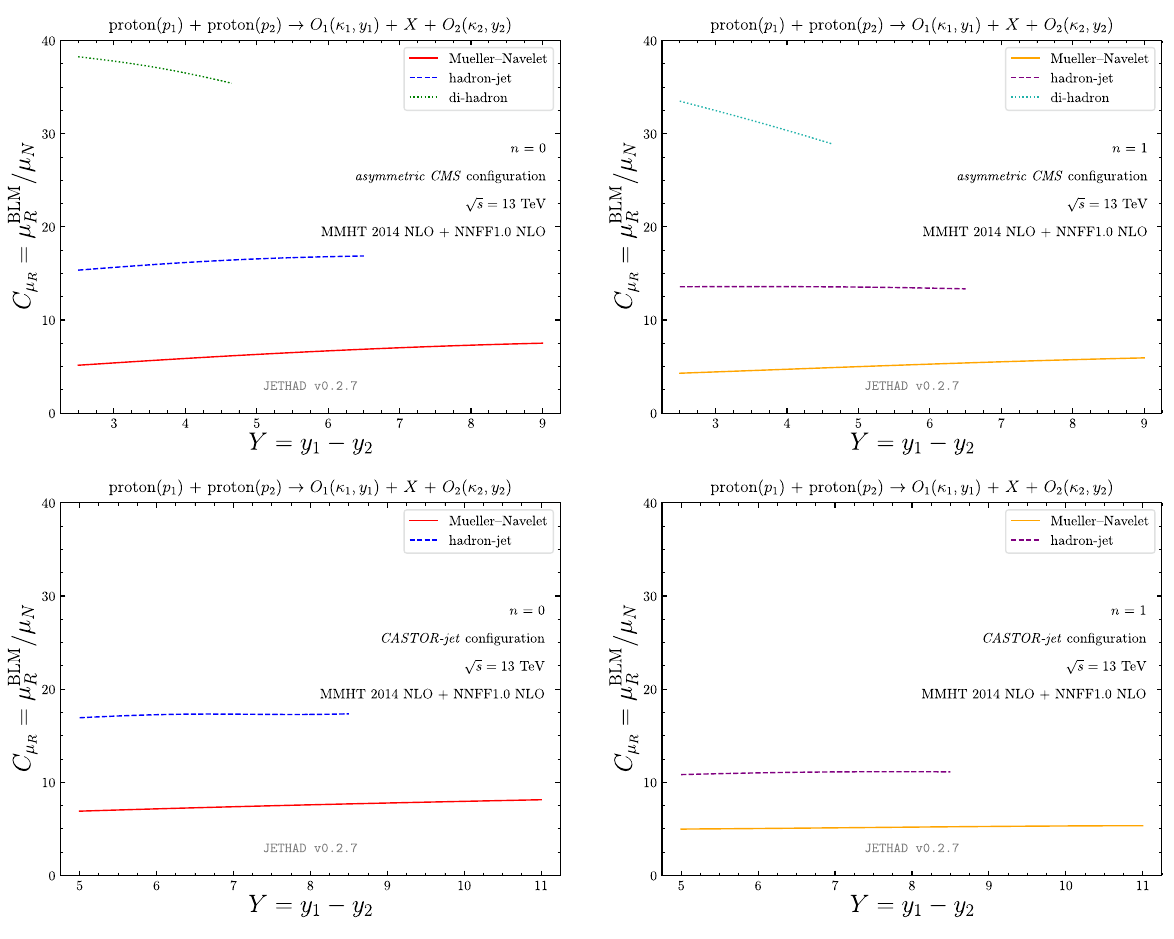
√ s = 13 TeV in the asymmetric CMS ( CASTOR-jet ) configuration are given in upper (lower) panels. Hadron emissions, when considered, are described in terms of NNFF1.0 [190] NLO FF parametrizations (see ≡ C μ μ Sect. 2.4 for further N . Results for R R